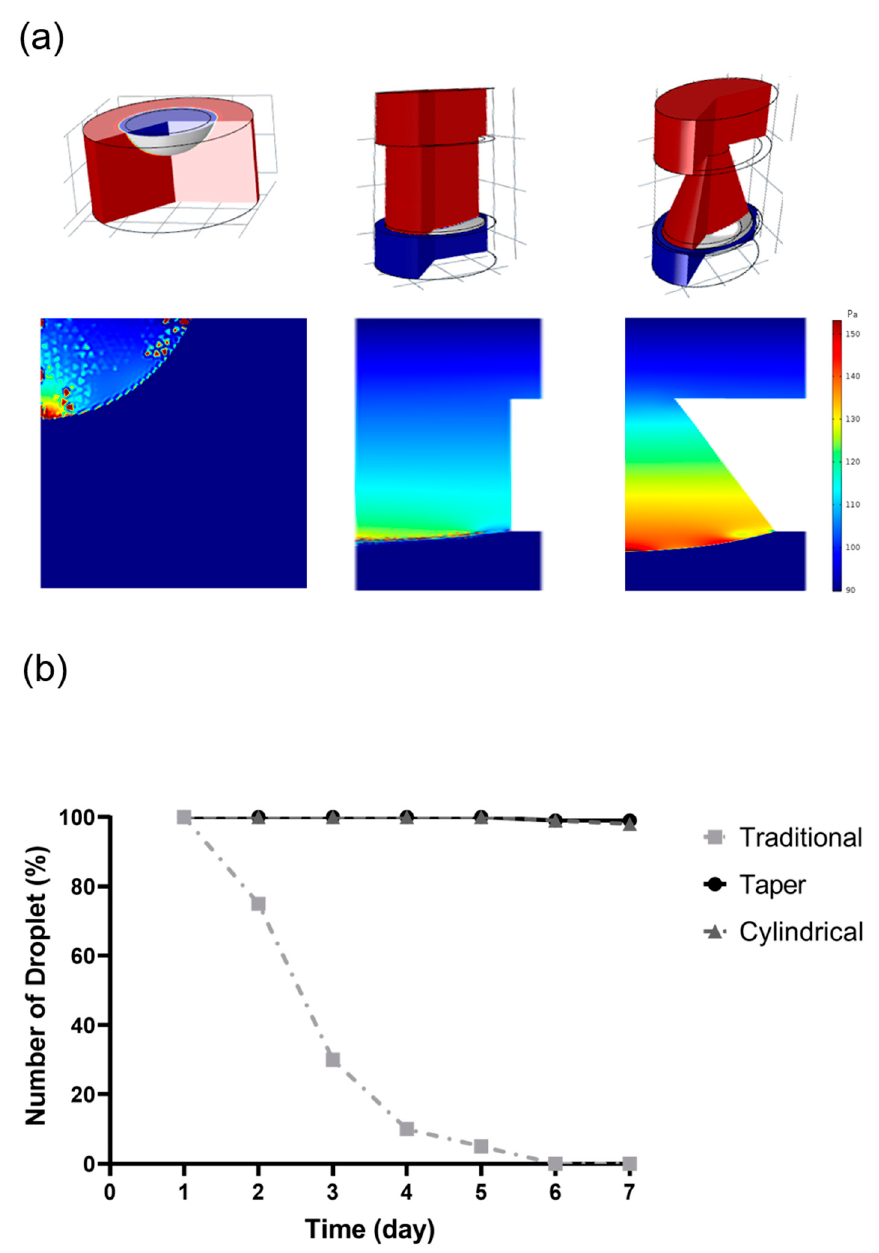
Figure 4. Droplets stability test: traditional hanging drop method, cylindrical tube microfluid chip, and taper-shaped microfluid chip ( a ) computer simulation, and ( b ) long-term stability test.